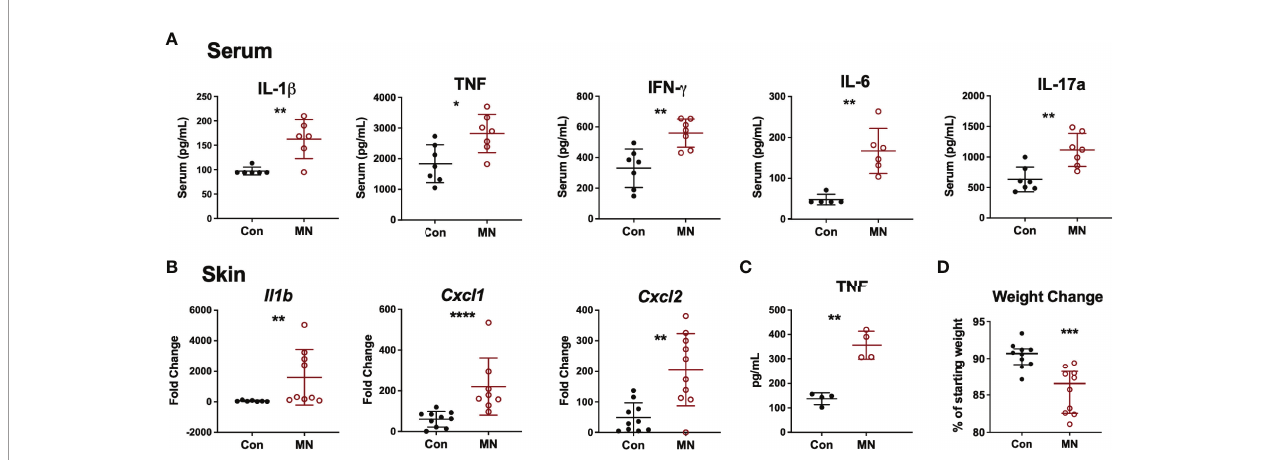
FIGURE 1 | Malnourished mice exhibit heightened baseline in fl ammation and an exaggerated in fl ammatory response to bacterial ligands. (A) In fl ammatory cytokines in serum of control (Con) or malnourished (MN) mice determined by Luminex assay (n=8-9 mice per group). (B) Cytokine mRNA expression determined by qRT-PCR in skin from the dorsal foot of control and MN mice (n=4-5 mice per group) 24 hours post-injection with 10 µg LPS in 20 µL of PBS or an equal volume of PBS alone. Fold-change determined by ratio of expression of target mRNA in LPS-administered vs. PBS. Data shown are pooled from 2 independent experiments. (C) TNF concentration determined by ELISA in supernatants of peritoneal macrophages isolated from control and MN mice cultured for 4 hours with or without 10 ng/ mL LPS or 20 µg/mL lipotechoic acid (LTA). TNF- a levels were below the limit of detection in the supernatant of untreated cells. (D) Weight change in control and MN mice that were challenged intraperitoneally with 4 mg/kg LPS. Shown is the percentage of starting weight at 24 hours post-challenge. Data presented is pooled from three independent experiments. (*p < 0.05; **p < 0.01; ***p < 0.001 ****p < 0.0001).